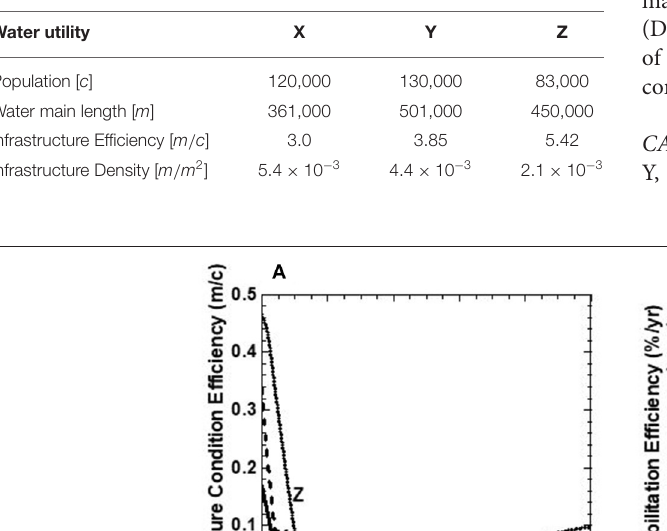
Frontiers in Water |